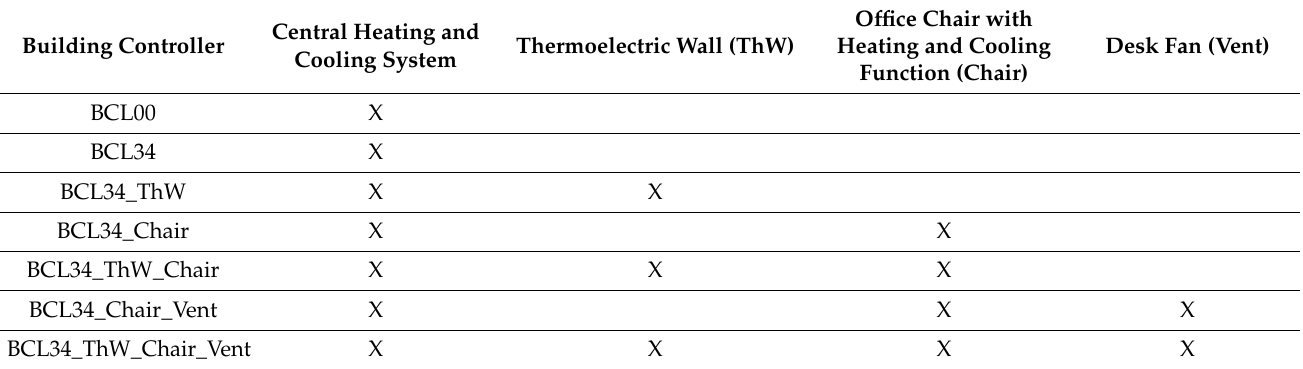
Table 2. Possible variations of the adaptive building controller BCL34 with decentralized systems (BCL34_*) and the basic controller BCL00; ThW for the thermoelectric wall; Chair for the office chair with heating and cooling function; Vent for the fan. “X” represents the used systems for each controller.